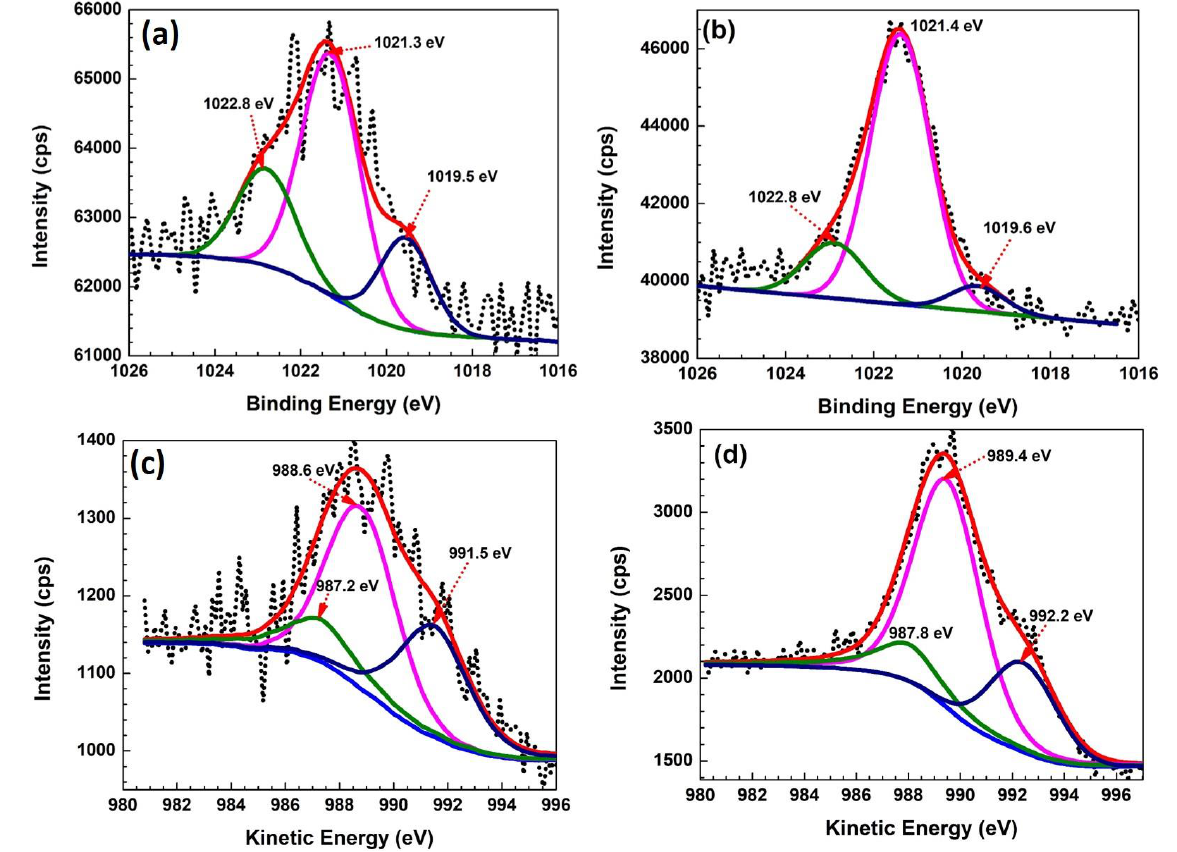
Figure 6. XPS spectra: ( a , c ) Zn 2p and Zn LMM for pure Fe 2 O 3 sample; and ( b , d ) Zn 2p and Zn LMM for Fe 2 O 3 sample doped with Zn (7%).